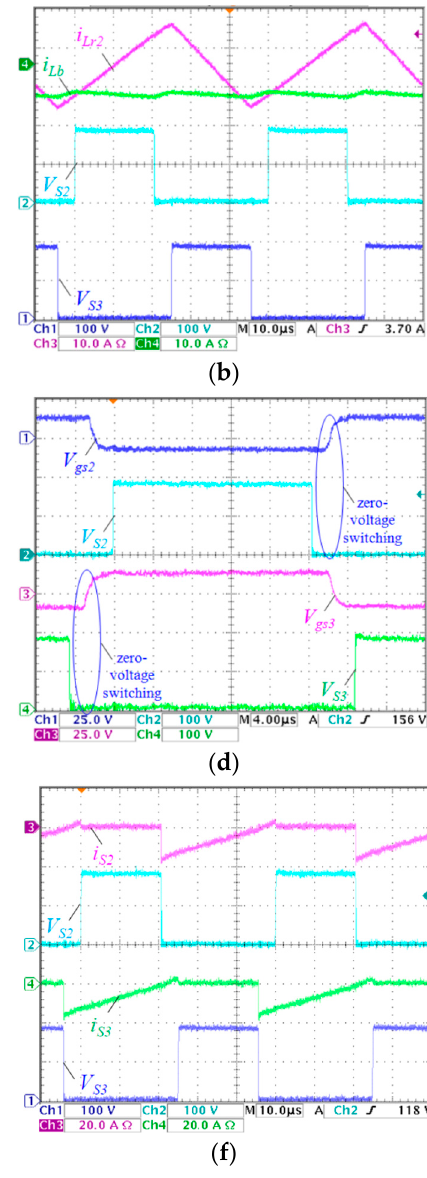
Figure 11. The experimental waveforms of the proposed converter in the step-down mode: ( a ) i Lb , i Lr1 , V S1 , and V S4 ; ( b ) i Lb , i Lr2 , V S2 , and V S3 ; ( c ) V gs1 , V S1 , V gs4 , and V S4 ; ( d ) V gs2 , V S2 , V gs3 , and V S3 ; ( e ) i S1 , V S1 , i S4 ,